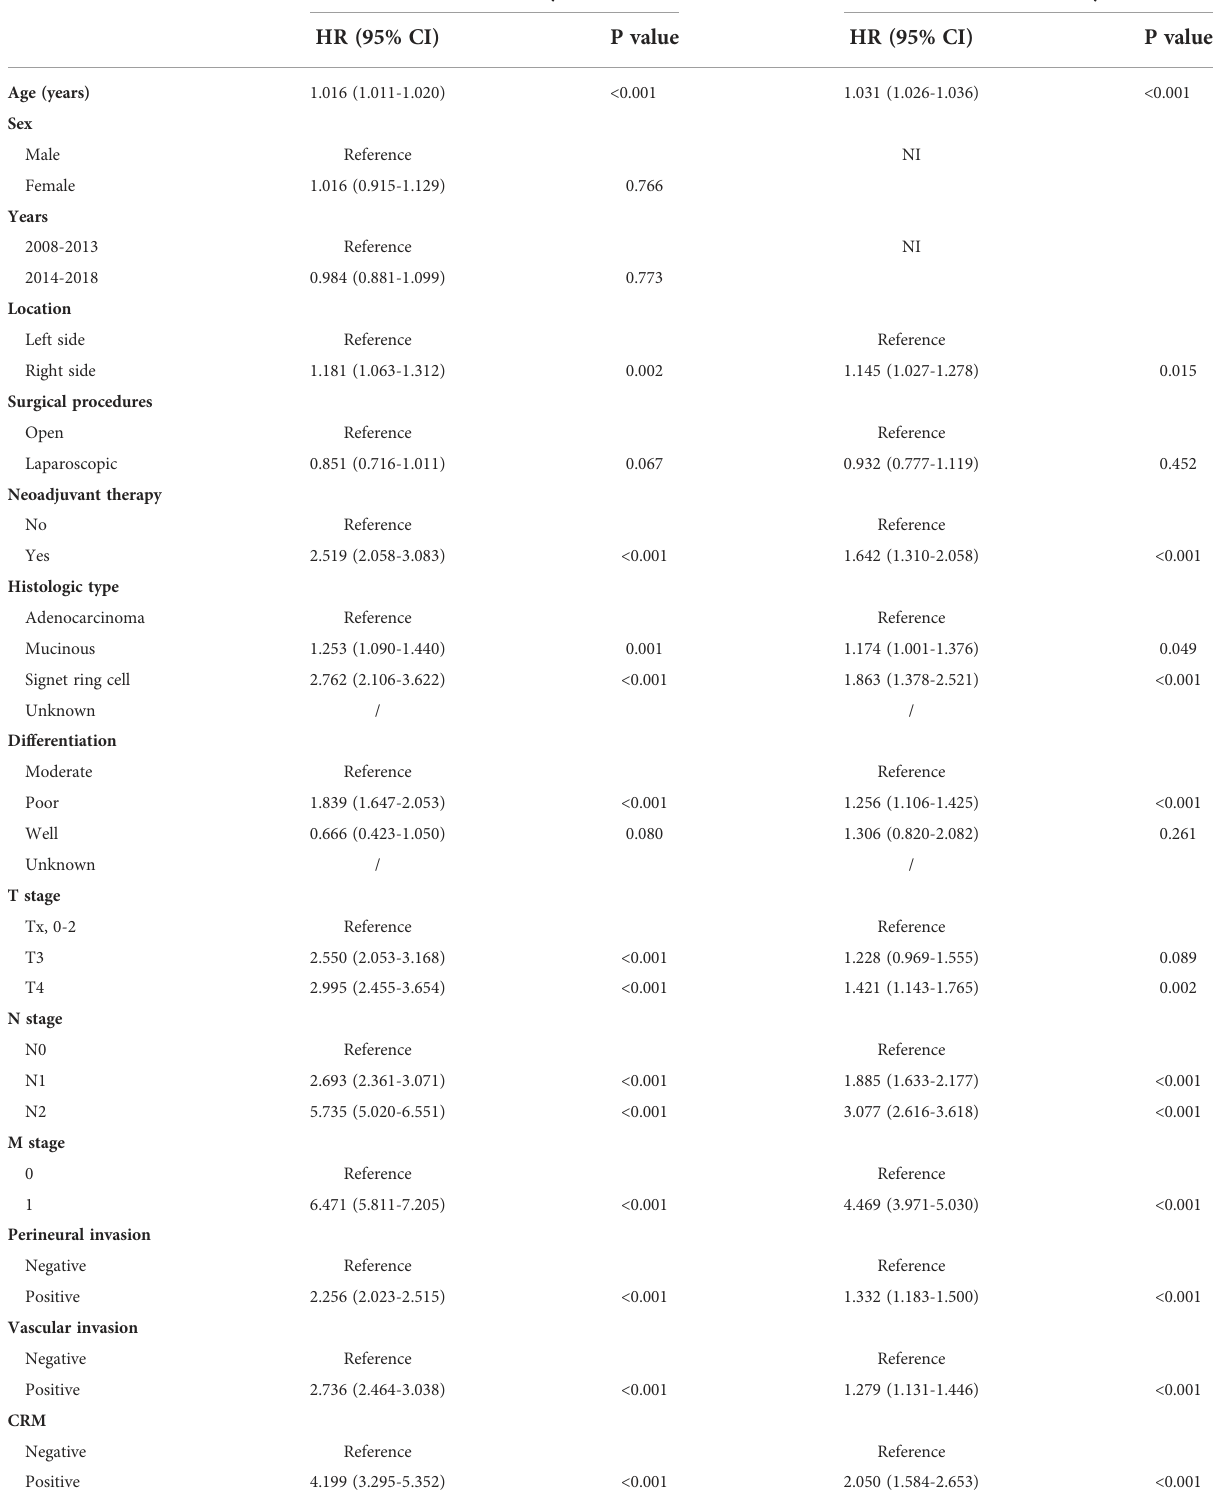
TABLE 3 Univariate and multivariate Cox analyses of the factors for overall survival in colon